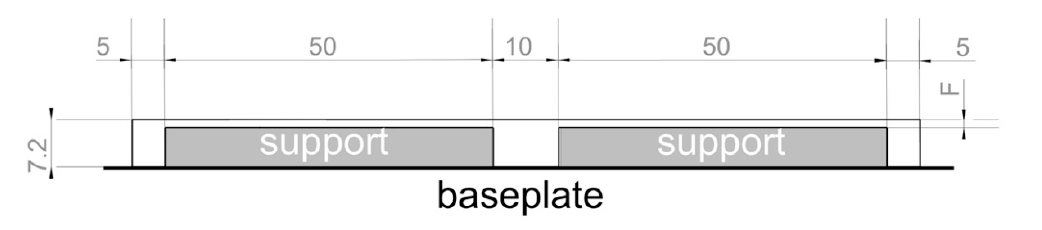
Figure 7. Recommended specimen geometry to be used for assessing plate temperature.